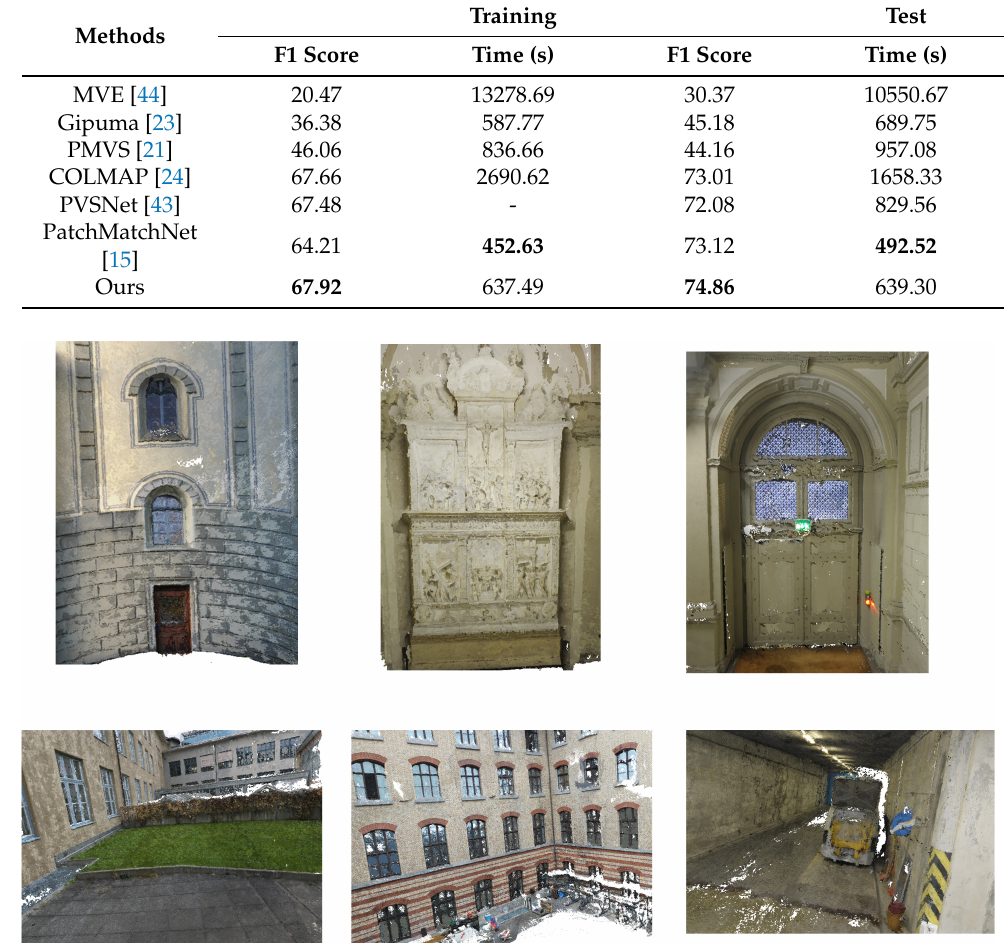
Figure 6. Reconstruction results on the ETH3D benchmark